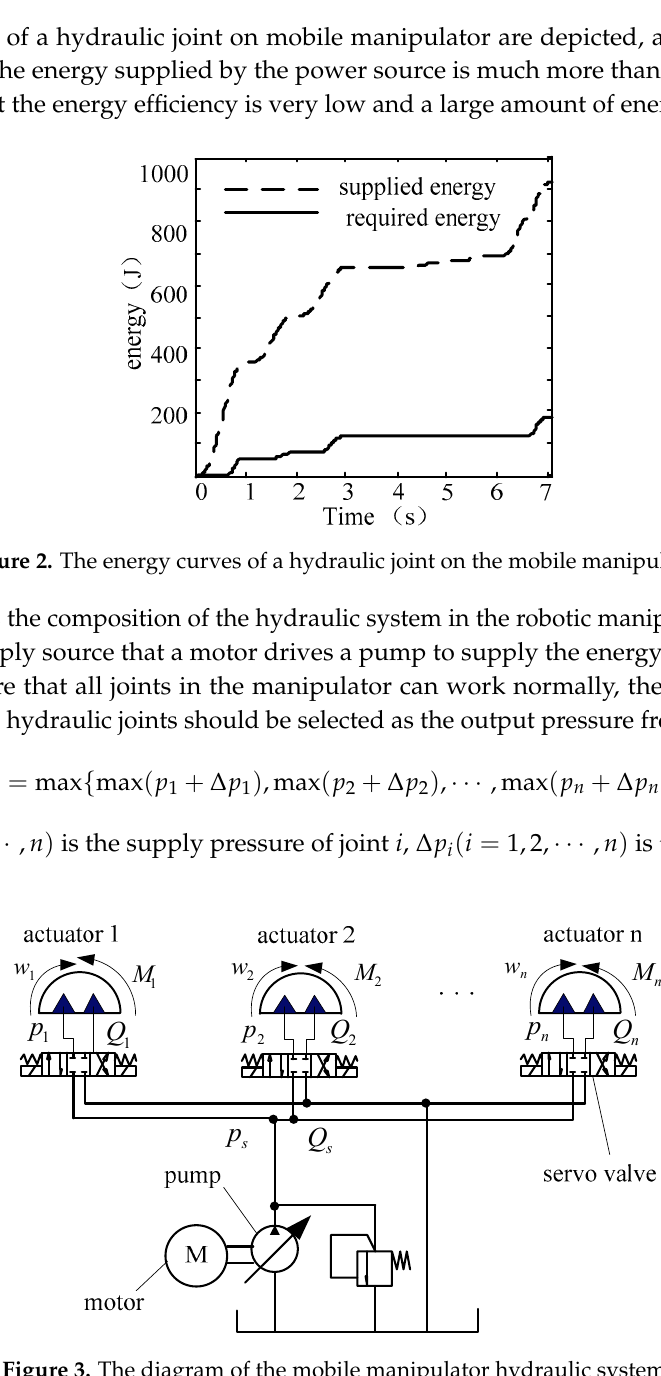
Figure 3. The diagram of the mobile manipulator hydraulic system.